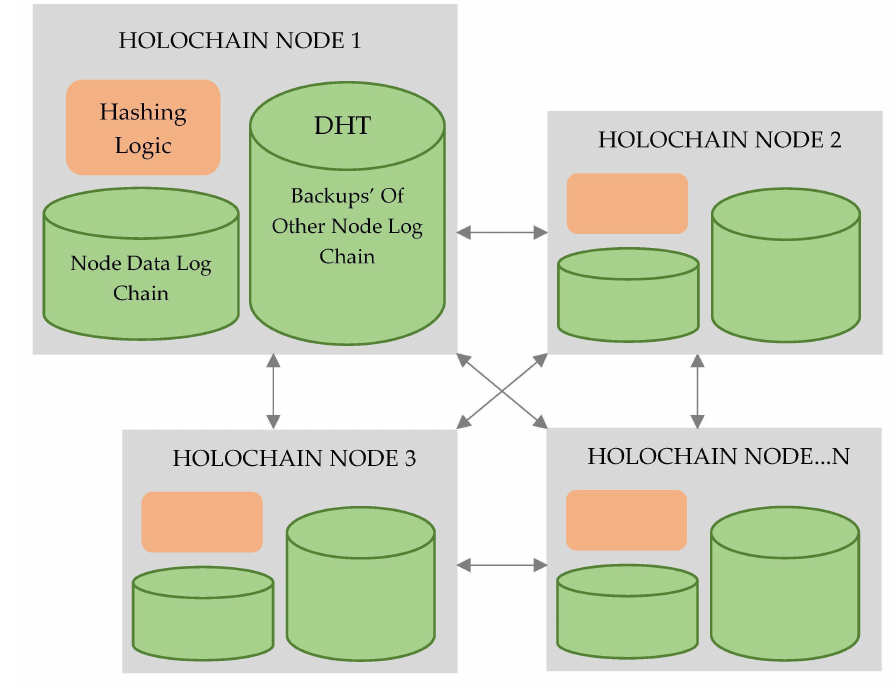
Figure 11. Log preservation in